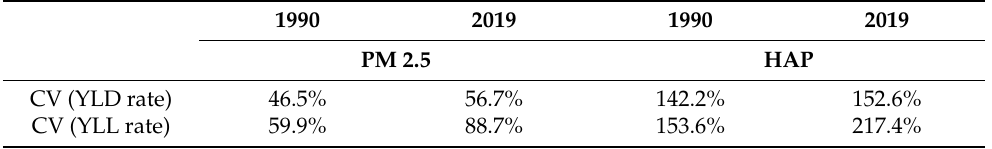
Figure 7. Catching-up effect in EU-27 of YLL and YLD per 100,000 people aged 20–54 in 2019 and change in 1990–2019 (beta convergence). ( a ) Ambient particulate matter pollution (PM2.5). ( b ) Household air pollution from solid fuels (HAP). Table 6. Coefficient of the variation of CV in EU-27, YLL and YLD per 100,000 people aged 20–54 in 1990 and 2019 (sigma convergence).